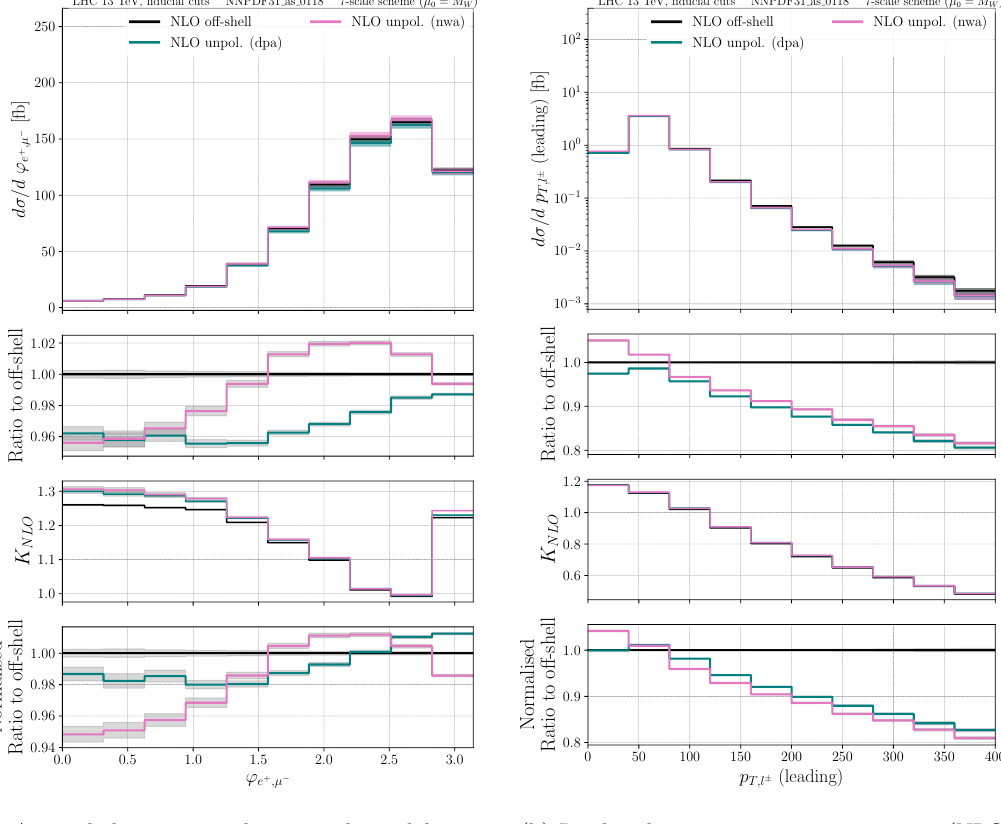
Figure 12 . Comparison between off-shell calculation, DPA, and NWA for selected distributions. Same plot substructure as in figure